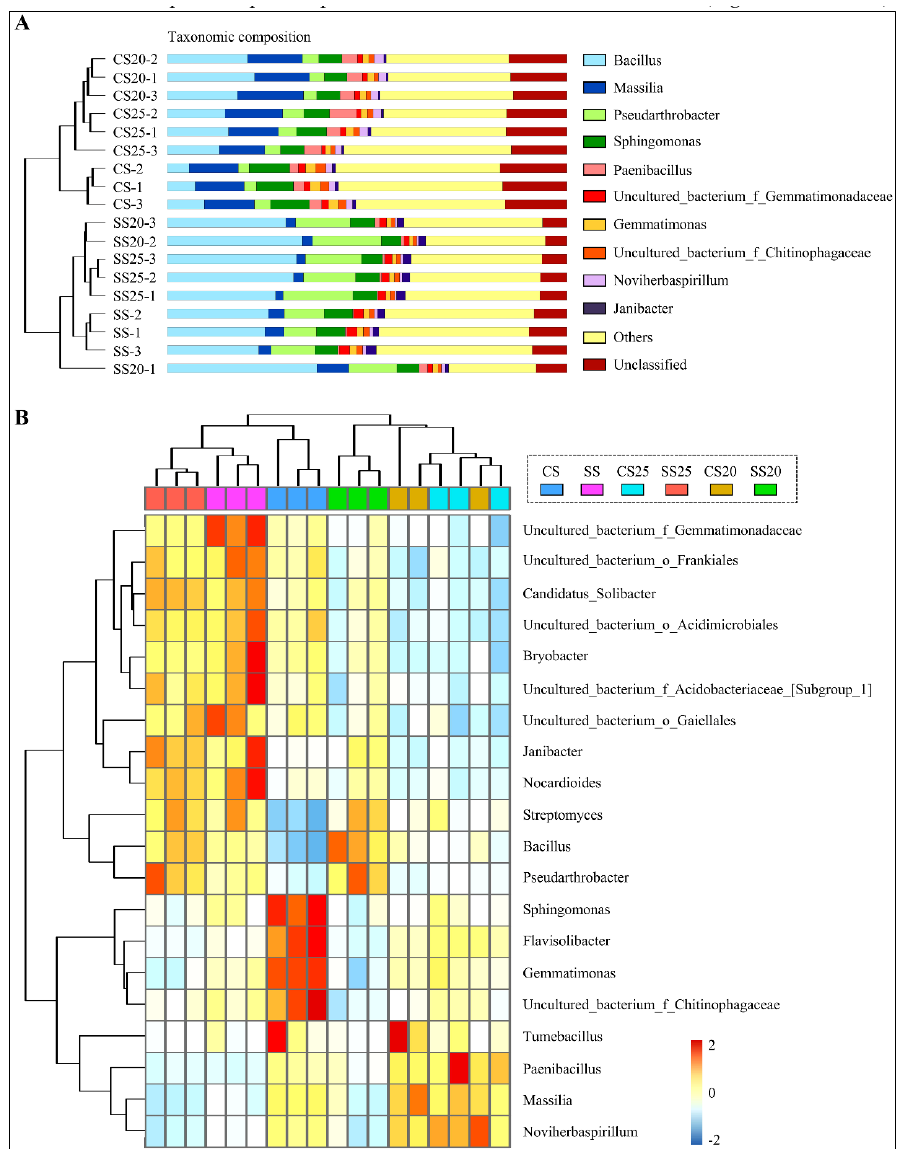
Figure 3. Bacterial community diversity analysis through bar charts and heatmap. ( A ) Percent of taxa at the genus level in peanut spermosphere soils and the bulk soils is visualized using bar charts. Samples are clustered according to the similarity among their constituents and arranged in vertical order. The shorter the branch length between samples, the higher the similarity of the two samples. ( B ) The relative abundance of the top 20 abundant genera is visualized using a heatmap. Samples are clustered according to the similarity among their constituents and arranged in a horizontal order. The taxa are also clustered according to the degree of similarity distributed among di ff erent soil samples and arranged in a vertical order. The red rectangle represents the more abundant genera and the blue rectangle represents the less abundant